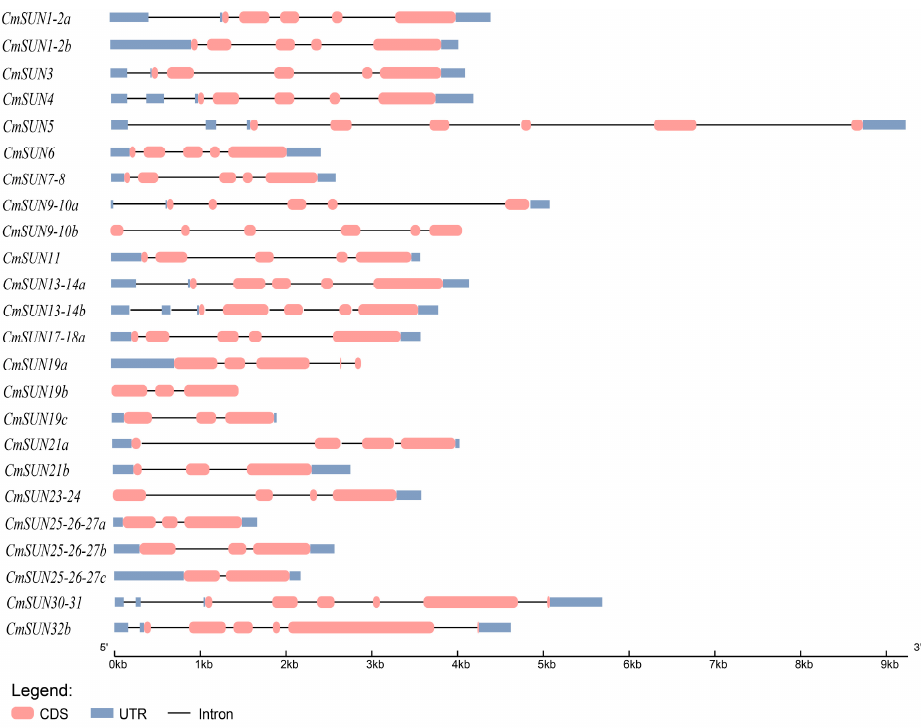
Figure 2. Gene structure of 24 CmSUN genes. The pink box represents the exon, the black lines represents the intron, blue box represents the UTR.